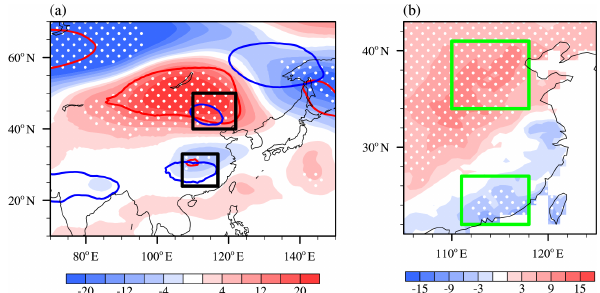
Figure 11. (a) Composites of geopotential height at 500hPa (unit: gpm, shadings) in summer associated with the SEI (positive SEI years minus negative SEI years) from 1980 to 2019. The red and blue lines indicate areas where the composite geopotential height anomalies associated with SI FJL and SIOD exceed the 90% con- fidence level, respectively. The black boxes represent the centers of AC NC and C PRD , respectively. (b) Composite differences of the detrended summer-mean MDA8 O 3 (unit: µgm − 3 ) simulated by GEOS-Chem model between high- and low-SEI years during 1980– 2019. The white dots indicate that the composite differences are above the 90% confidence level. The green boxes represent the ar- eas of NC and the